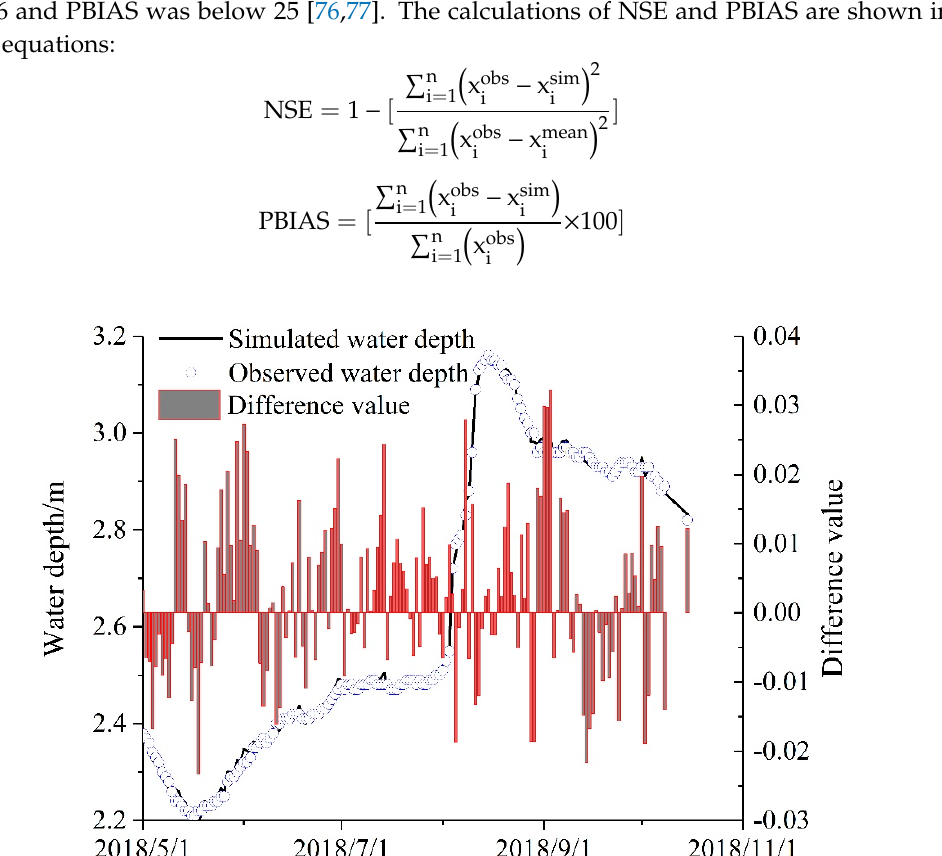
Figure 4. Comparison of simulated and observed water depth and their differences (simulation minus observations) of Chagan Lake from May–October 2018.